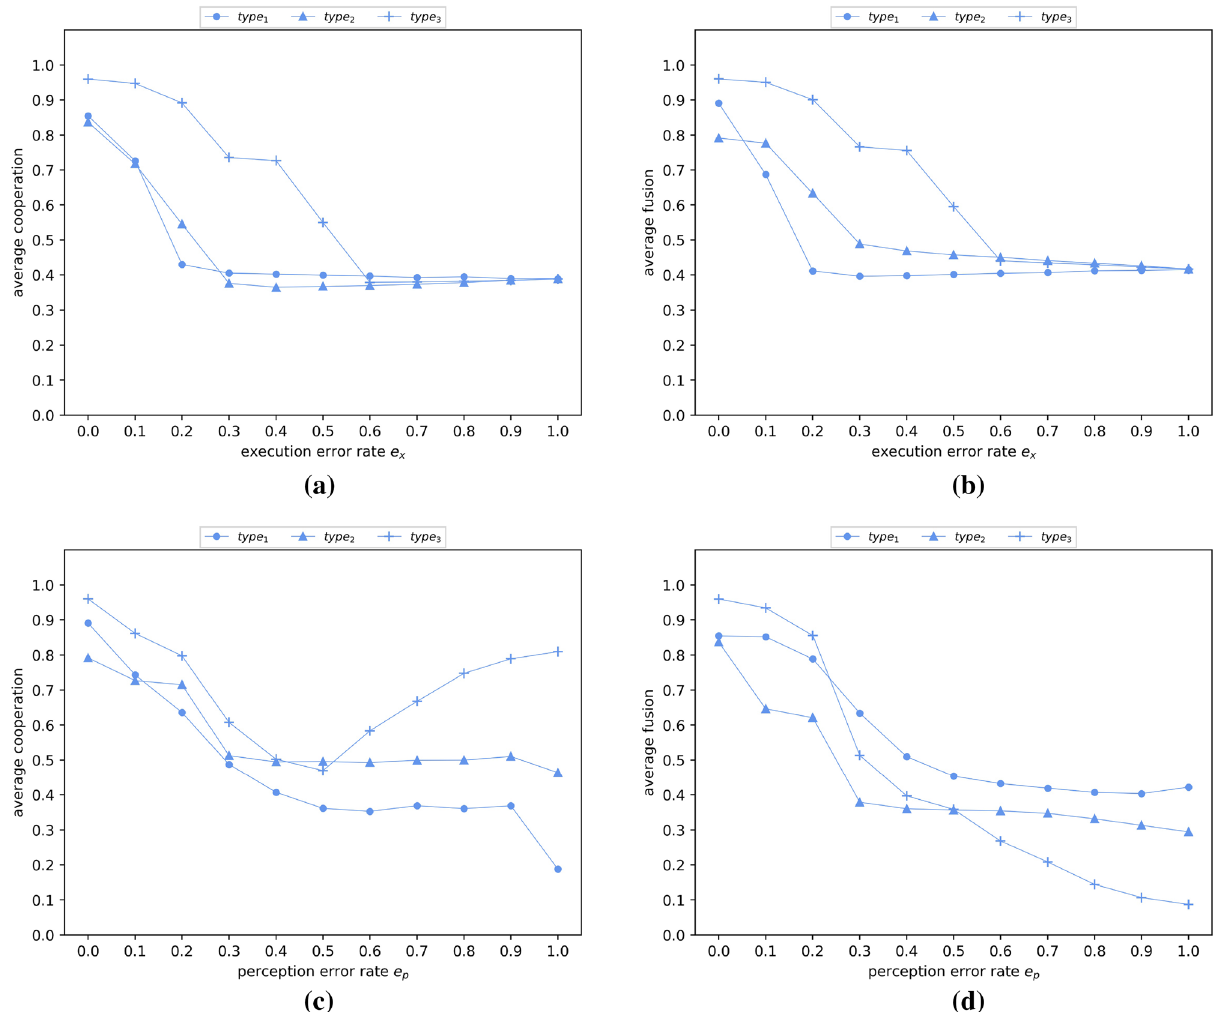
Figure 5. Average cooperation ( a ) and fusion ( b ) as a function of the rate of execution error e x . Average cooperation ( c ) and fusion ( d ) as a function of the rate of perception error e p . Ostracism of type 1, 2, or 3 is performed by each agent i with a probability equal to the agent’s fusion level f i . Perception error e p is defined as the probability of the individual’s contribution to the group being replaced by a random number in the range [0,1]. Execution error e x is defined as the probability for an agent not to perform ostracism when it should. Agents interact randomly with the other fused individuals within their in-group with a probability equal to their own fusion levels ( S i = f i ). The in-group of an agent i is defined as the subset of agents having at least same level of fusion as i (i.e., f i or greater). Agents interact randomly with the whole population with a probability equal to 1 − S i . Results are averaged over five randomly seeded runs, each conducted for 50,000 generations. Parameter settings are consistent with Fig.